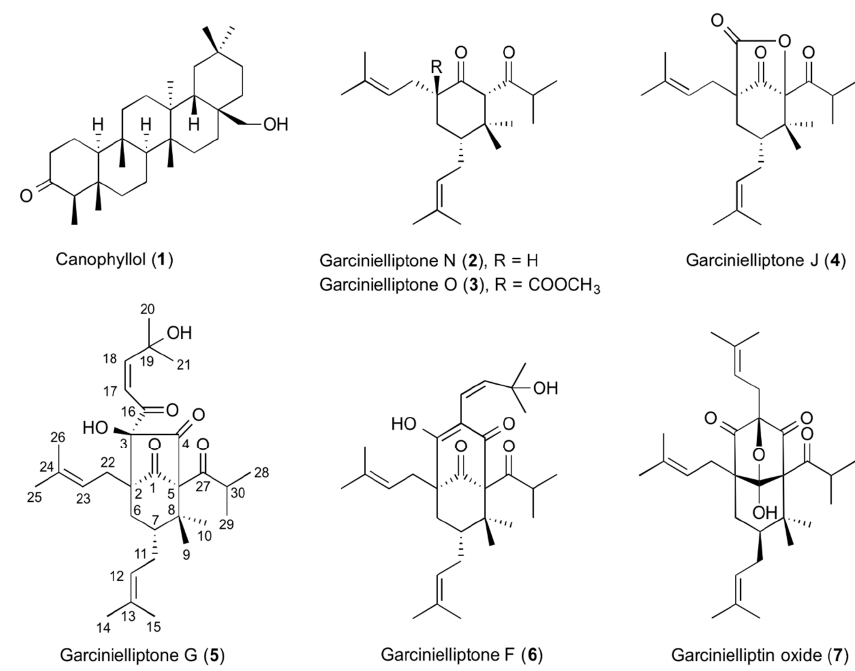
Figure 1. Compounds isolated from Garcinia subelliptica leaves.